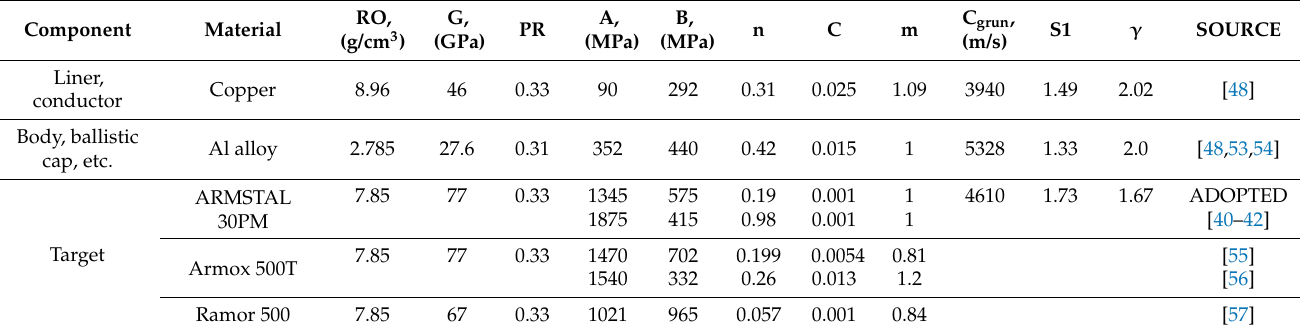
Table 10. Material parameters of the metallic components of the PG-7VM warhead used in simulations. Component